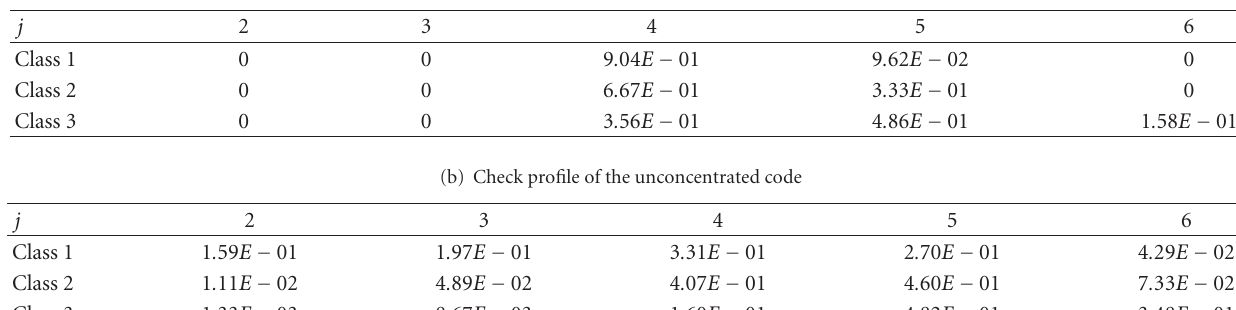
Table 1: Check-node profiles of concentrated and nonconcentrated codes used in Figure 11.